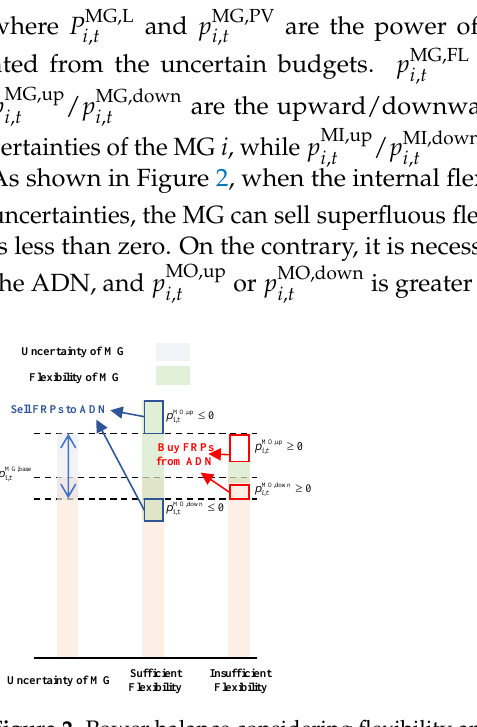
Figure 2. Power balance considering flexibility and uncertainty of